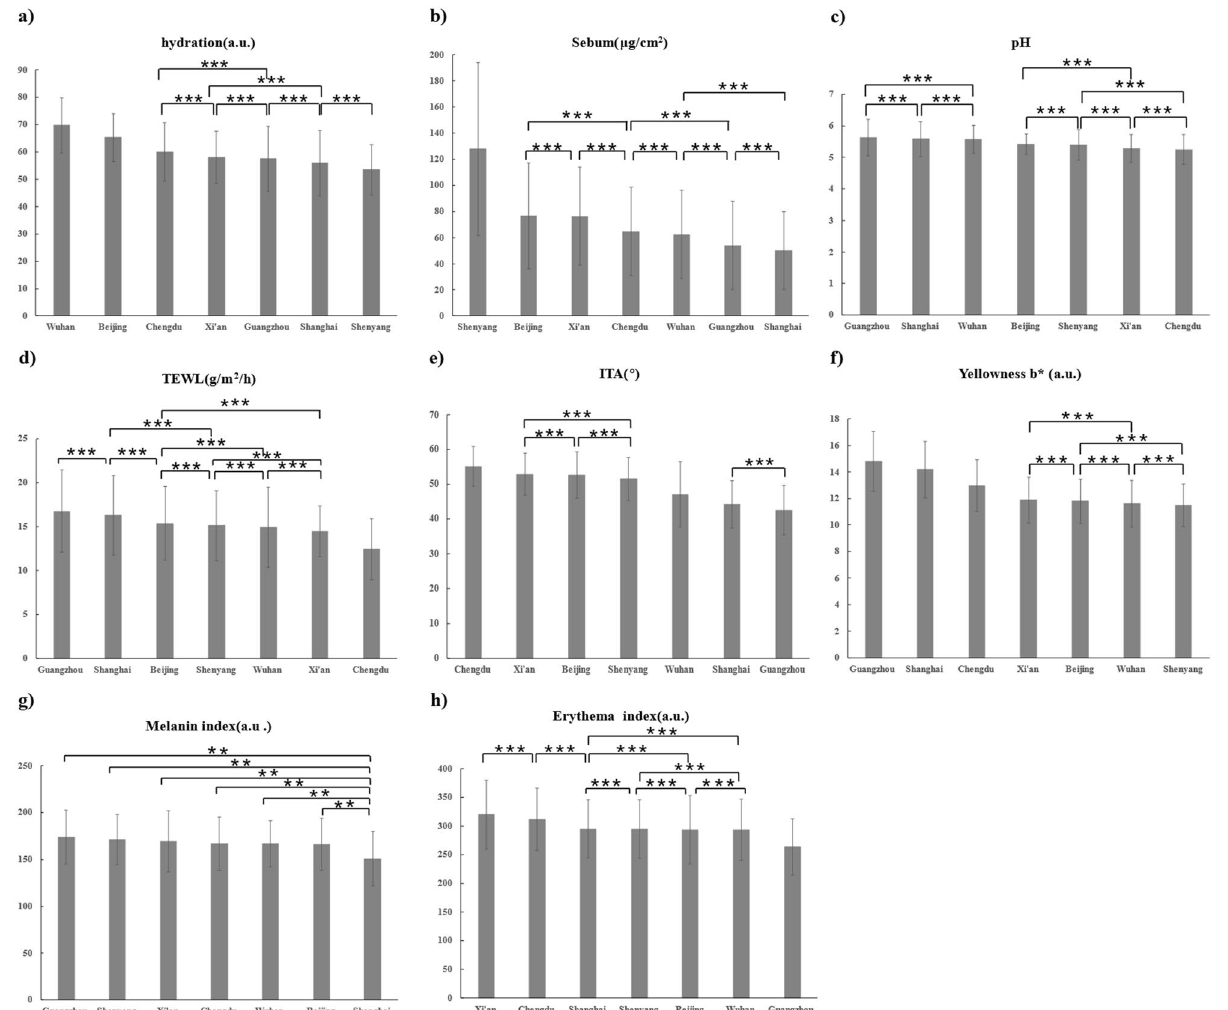
Figure 3. Comparison of skin physiological index differences among participants from seven cities. Skin hydration content ( a ); skin sebum content ( b ); skin pH value ( c ); skin TEWL value ( d ); individual typological angle ITA ( e ); skin yellowness (b*) value ( f ); skin melanin index value ( g ); skin erythema index value ( h ). **Indicates a significant difference between the two cities ( P < 0.05). ***Indicates no significant difference between the two cities ( P >